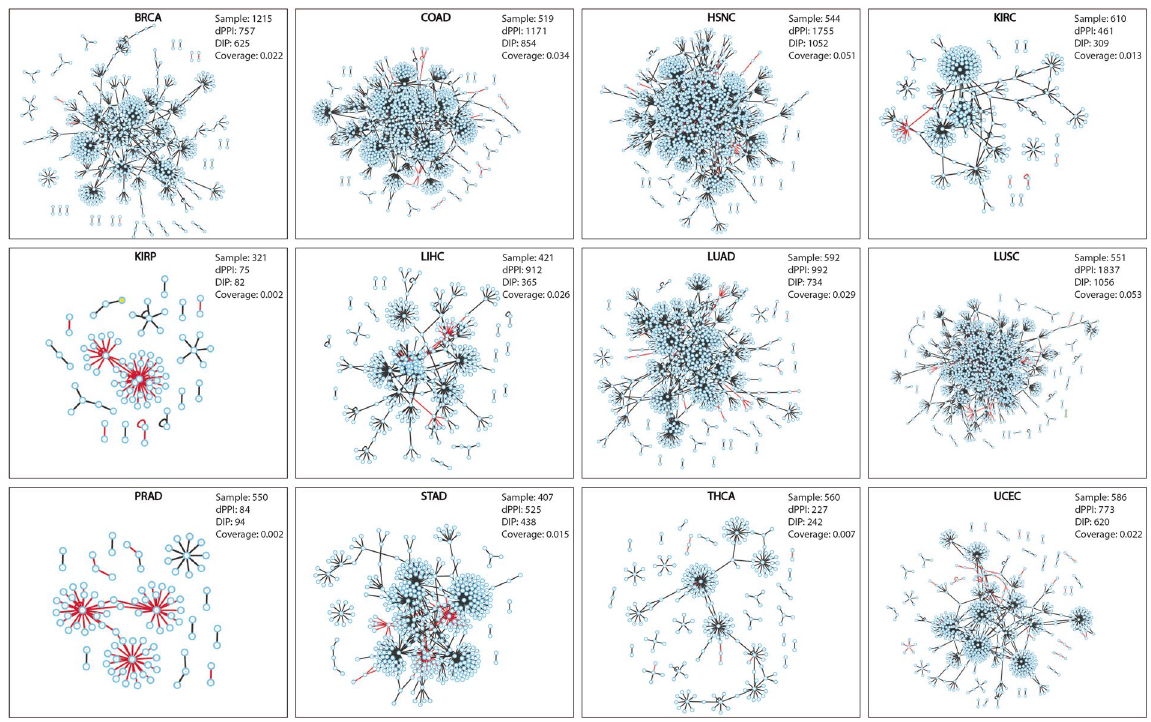
Figure 2. Differential interactome networks in 12 human cancers. Differential interactome network was constructed around dPPIs for each cancer. Red edges represent repressed interactions; black edges represent activated